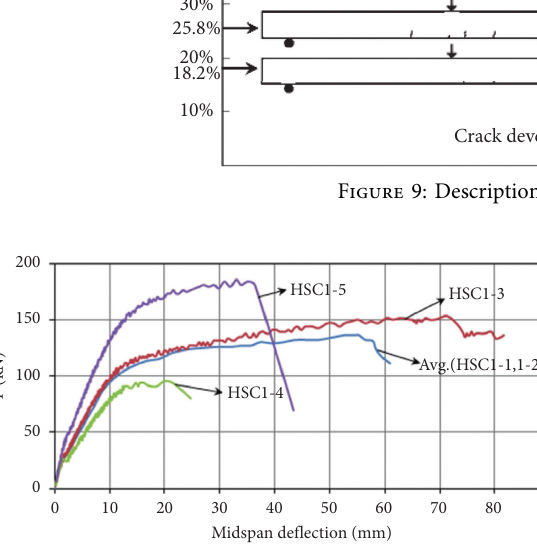
top.Top concrete crushed. yielded.Transverse cracks appeared in the interface.Steel faceplate slab.Crack developed to 3/4 height of the slab and separation cracks appeared in the